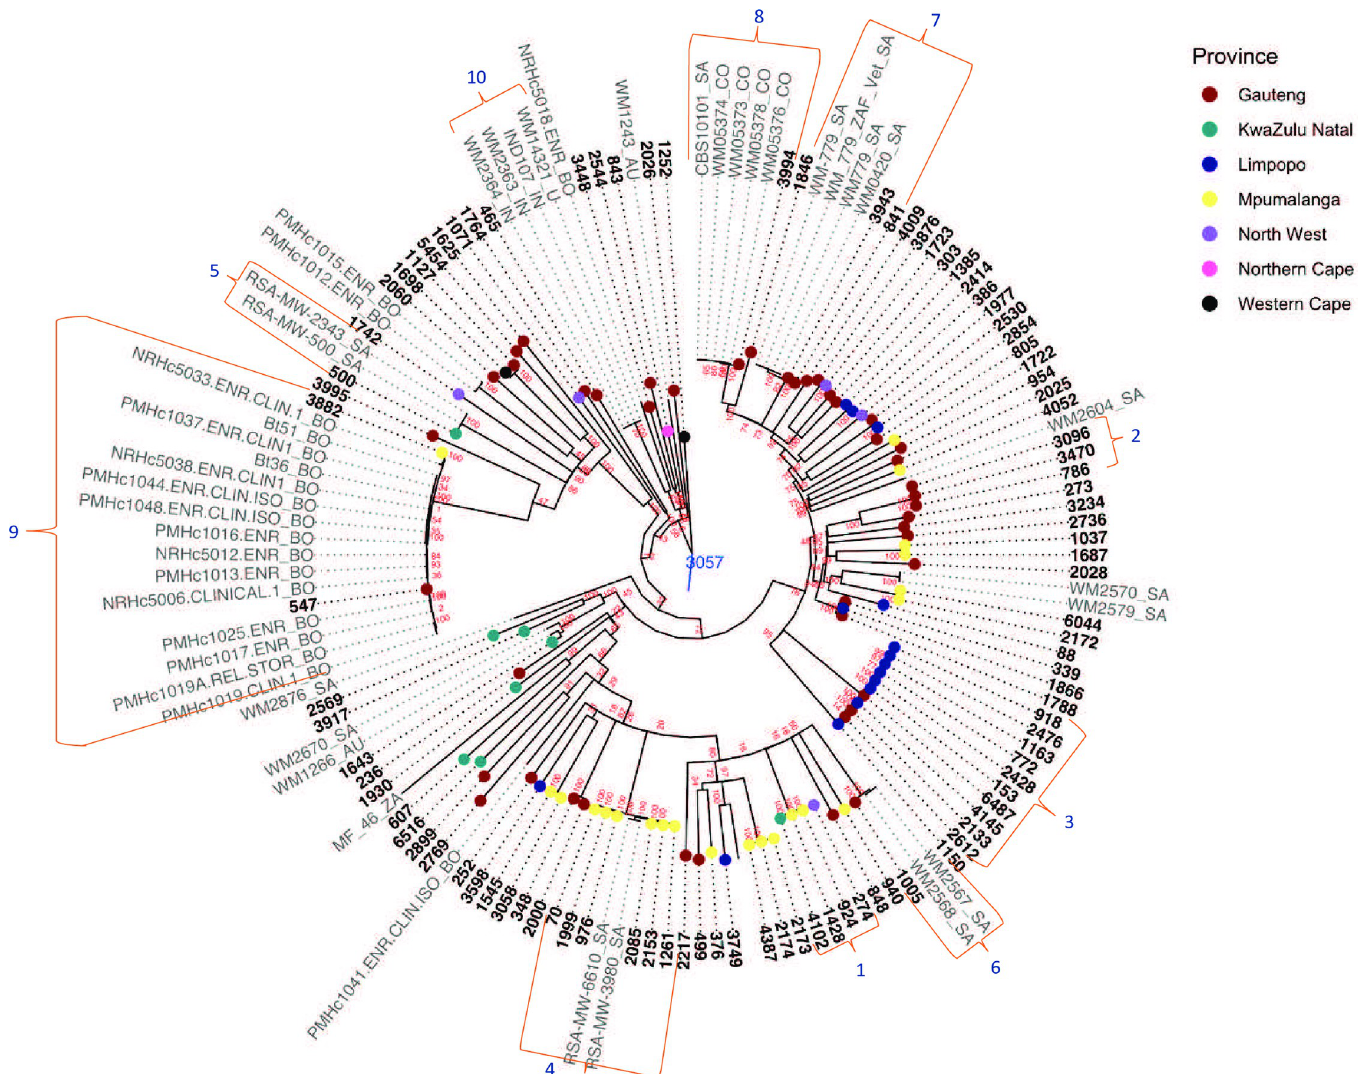
Fig 2. Rooted maximum parsimony tree generated from the WGS SNP analysis of 98 South African clinical VGIV Cryptococcus gattii isolates (coloured circles and bolded tip labels) and 47 global samples. IND107 was used as the reference. BWA was used to align reads to the reference and SAMtools was used to call SNPs. There were 123,891 SNPs in total with a coverage breadth of 61%. Bootstrap analysis was peformed with 100 bootstrap replicates. The bootstrap values are shown next to the branches. The consistency index was 0.35 and the number of phylogenetic informative positions were 123,891. BO–Botswana, SA–South Africa, CO–Colombia, AU– Australia, IN–India, ZA–Zambia,